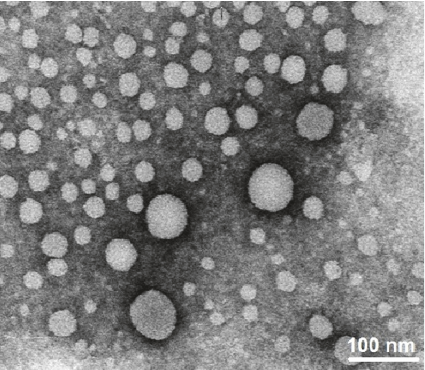
Figure 1: SNP images obtained by transmission electronic micro- scope (TEM). Magnification: